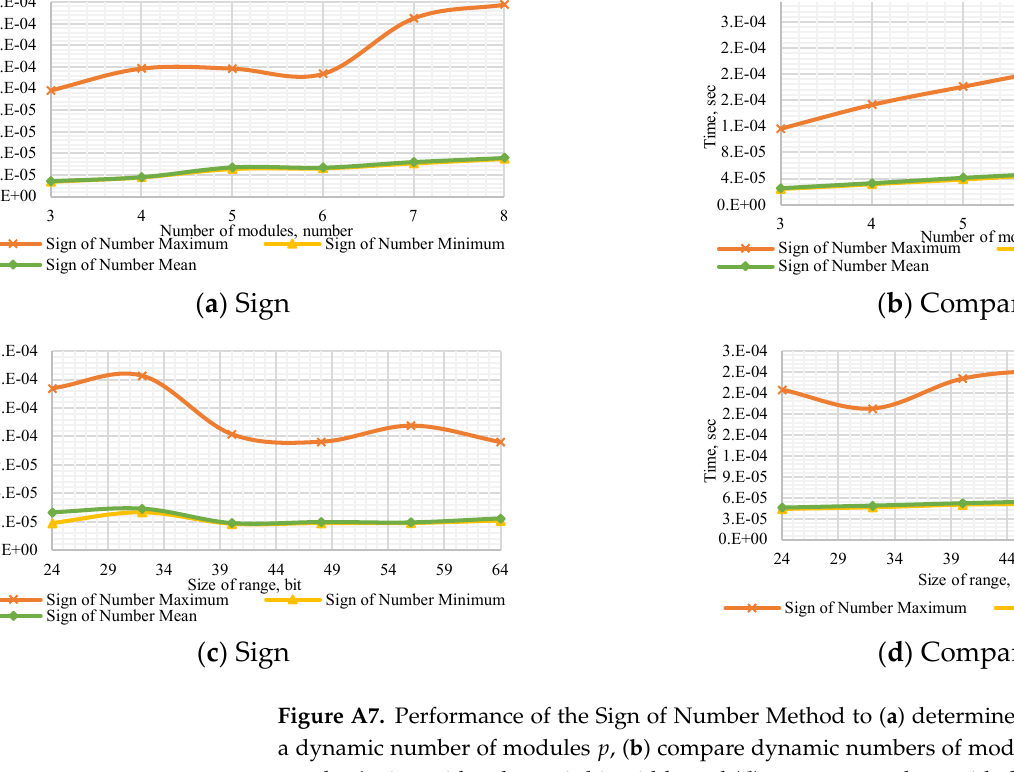
number’s sign with a dynamic bit width, and ( d ) compare numbers with dynamic bit width.